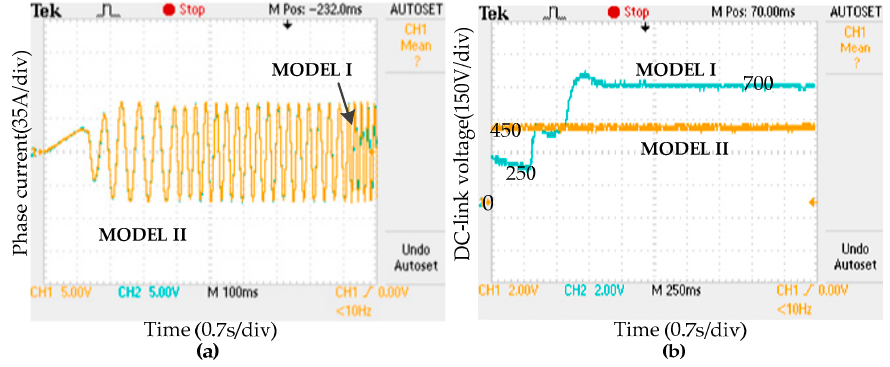
Figure 23. The phase current and the bus voltage of two models under T e* = 90 Nm. ( a ) the phase current; ( b )the bus voltage.